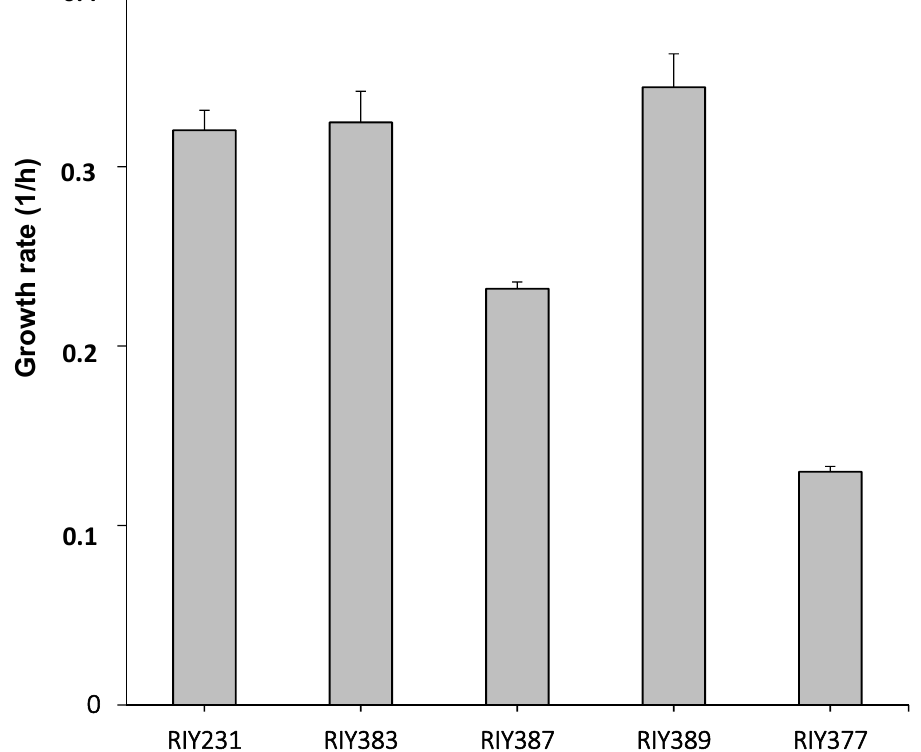
Figure 3. Growth rate of Y. lipolytica strains RIY231 (p TEF - ylGSH 1- ylGSH 2), RIY383 (p TEF-ylGSH1- ylGSH2-GUT1-GUT2 ), RIY387 (p TEF-ylGSH1-ylGSH2-gAMY- α AMY ), RIY389 (p TEF-ylGSH1-ylGSH2-INU1 ), RIY377 (p TEF-ylGSH1-ylGSH2- β GAL ) grown for 24 h in YNB medium supplemented with 10 g/L of glucose, glycerol, starch, inulin or lactose, respectively. Data are the mean and standard deviation of three experiments.